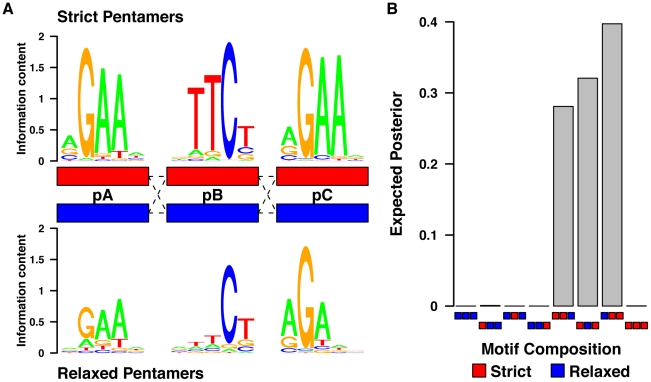
Pentamers within the HSEs are dependent upon their consensus match and also their position relative to the other pentamers.A) The mixture model defines each pentamer within the HSE as strict or relaxed depending upon how well it conforms to the canonical HSE. Note that the position of relaxed pentamers strongly influences their composition. B) A probabilistic sequence model reveals that the presence of two strict (red) and one relaxed (blue) pentamer provides the best explanation of the data.